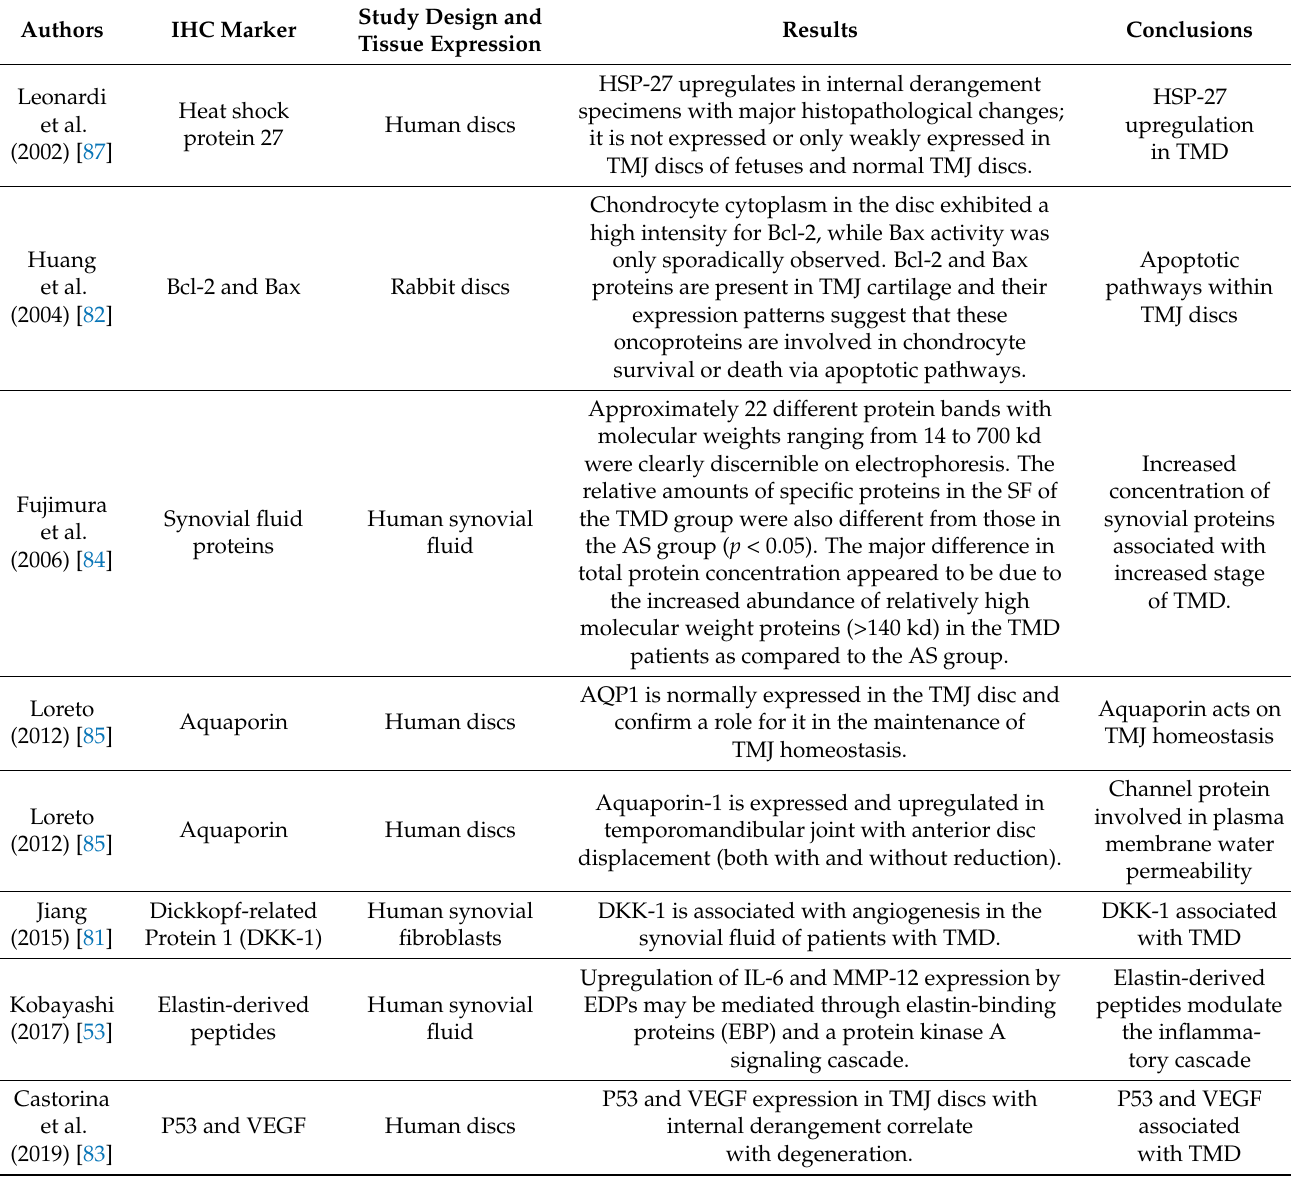
Table 5. Miscellaneous (aquaporin, DKK1,